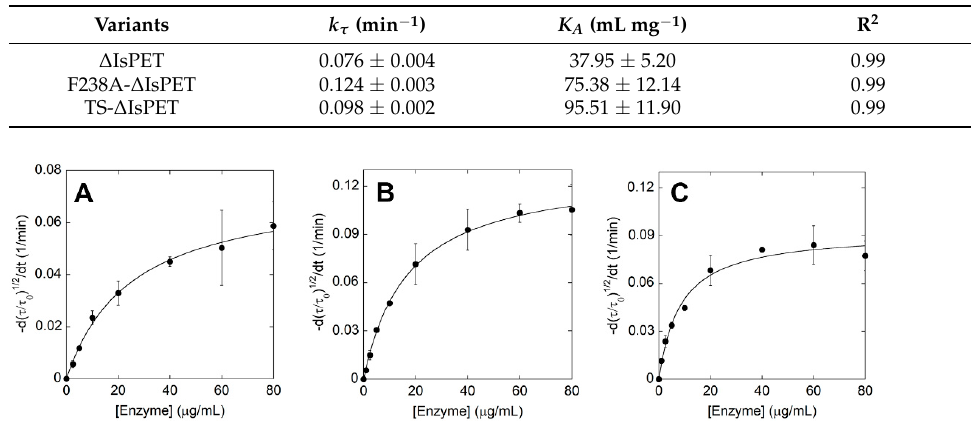
Table 1. Kinetic parameters for the enzymatic hydrolysis of PET nanoparticles by selected ∆ IsPET variants. Data were fitted using Equation (2). R 2 represents the nonlinear regression coefficient.